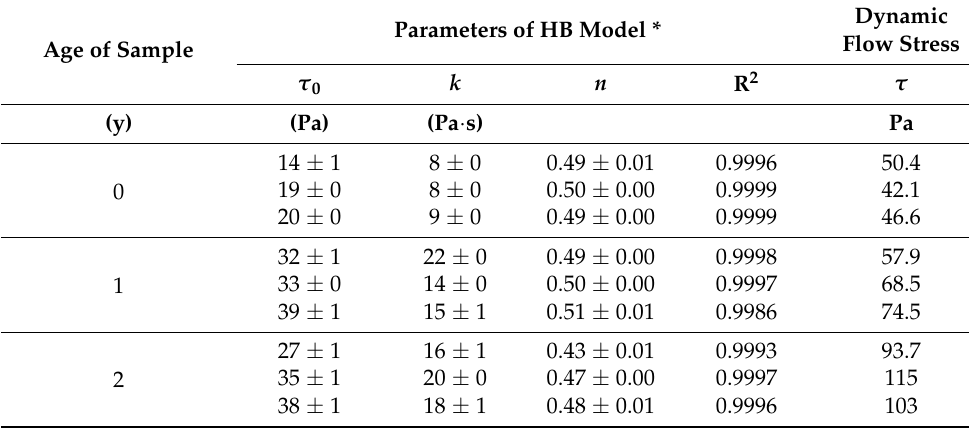
Table 3. Evolution with aging of Herschel–Bulkley parameters and dynamic flow stress.